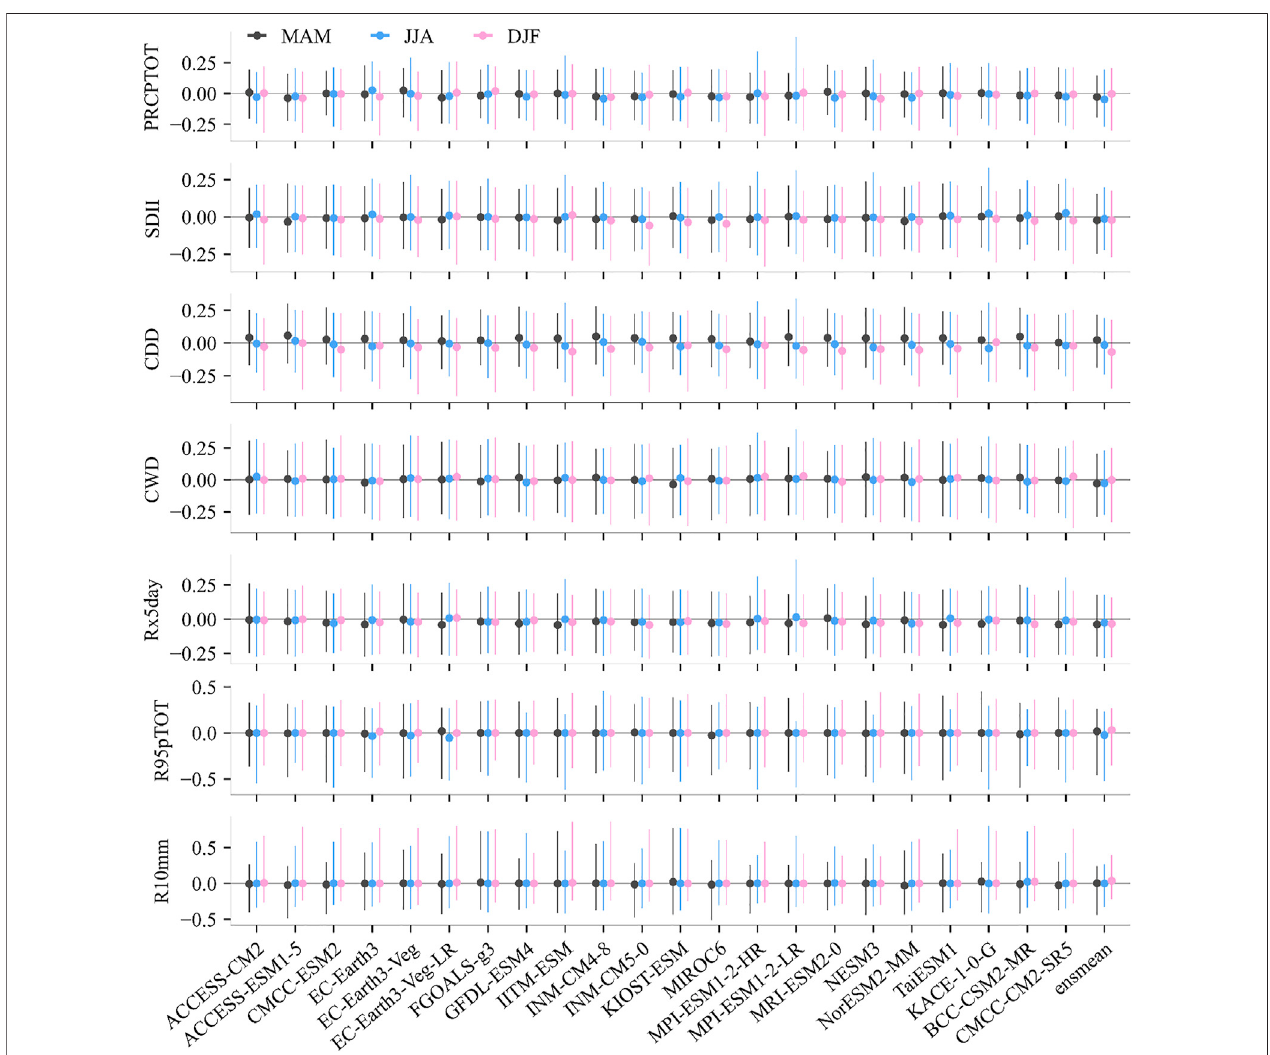
FIGURE 4 | Percentage difference in L-kurtosis ( τ 4 ) of total precipitation and extreme precipitation indices between the GPM and CMIP6 models (including the multi-modelensemblemean) inspring(MAM), summer(JJA), andwinter(DJF). Thetotalprecipitationand SDII, CDD, CWD,Rx5day, R95pTOT, and R10mm areshown from top to bottom. The point represents the median, and the error bar indicates the 90% empirical con fi dence interval. The trianglein the graph indicates a bias greater than 150%.